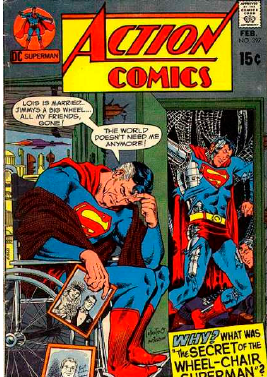
Figure 9. Action Comics #396, “The Super-Panhandler of Metropolis!” (January 1971) [10] .